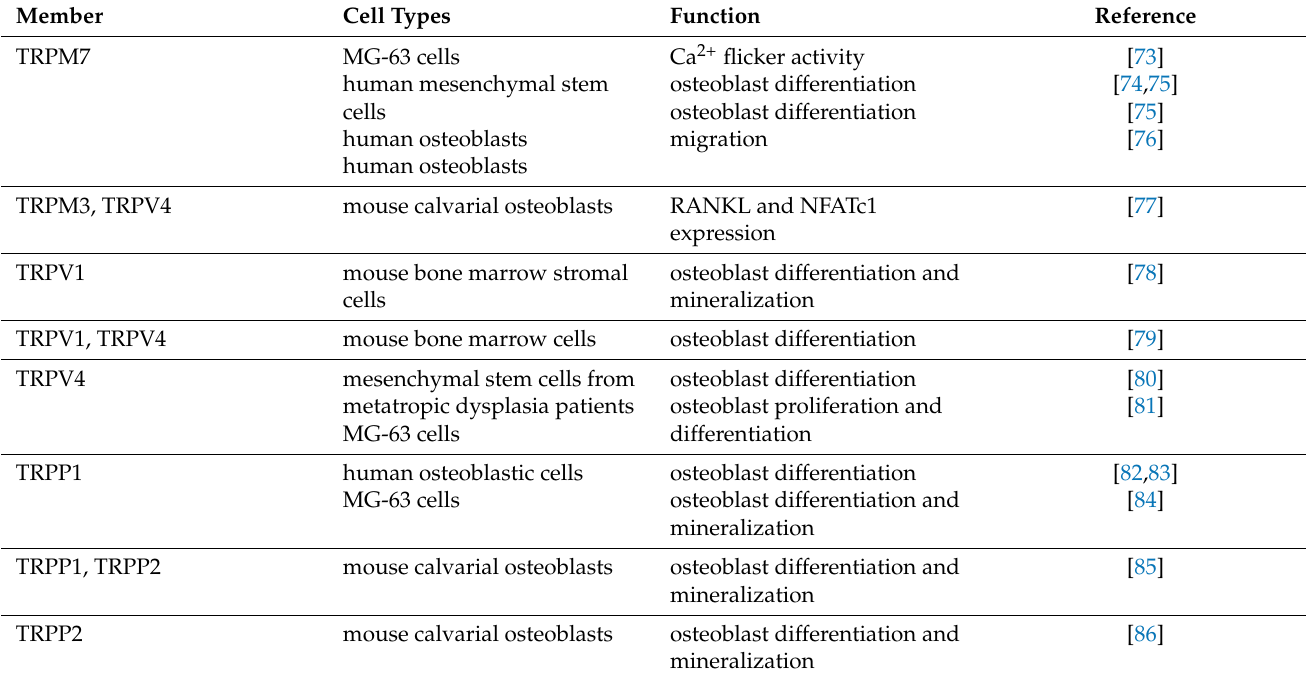
Table 4. Functional expression of TRP channels in osteoblast lineage cells.